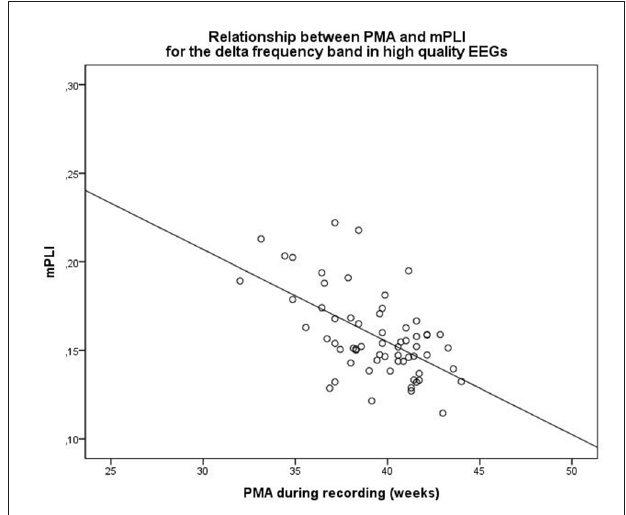
FIGURE 2 | Scatterplot of PMA and mPLI in the delta frequency band, in a subgroup of subjects with EEGs assessed as high quality. Dots correspond to individual subjects ( N = 63). PMA = postmenstrual age, mPLI = mean phase lag index.